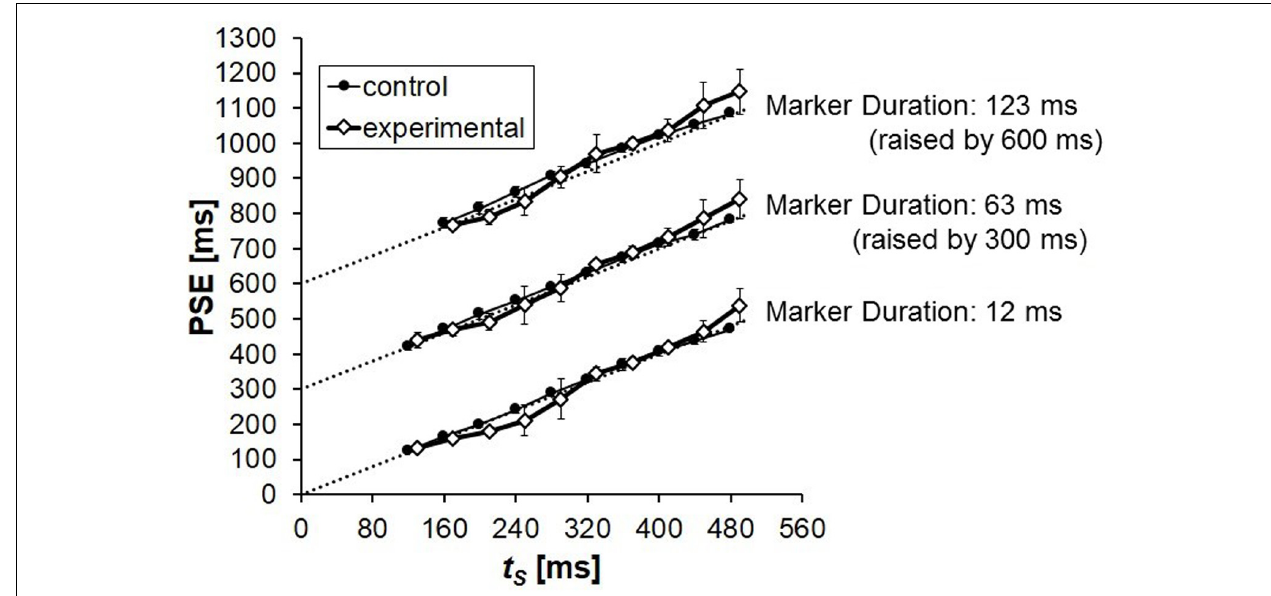
FIGURE 2 | Mean PSEs obtained from five participants in Experiment 1. PSE corresponds to the duration of t C that was perceived to be equal to the duration of t S .The results for marker durations 63 and 123 ms were raised by